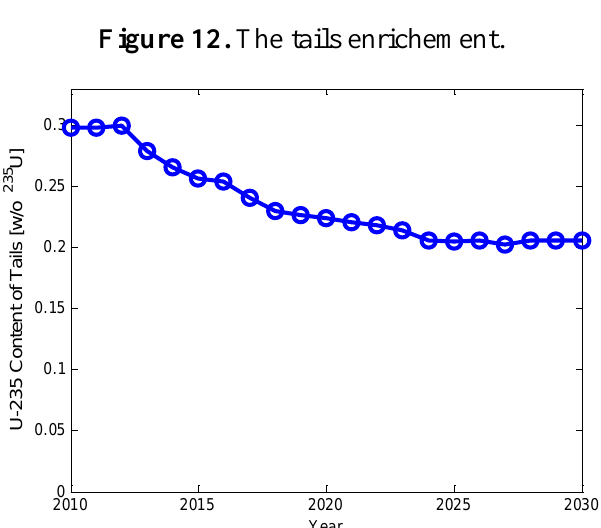
Figure 12. The tails